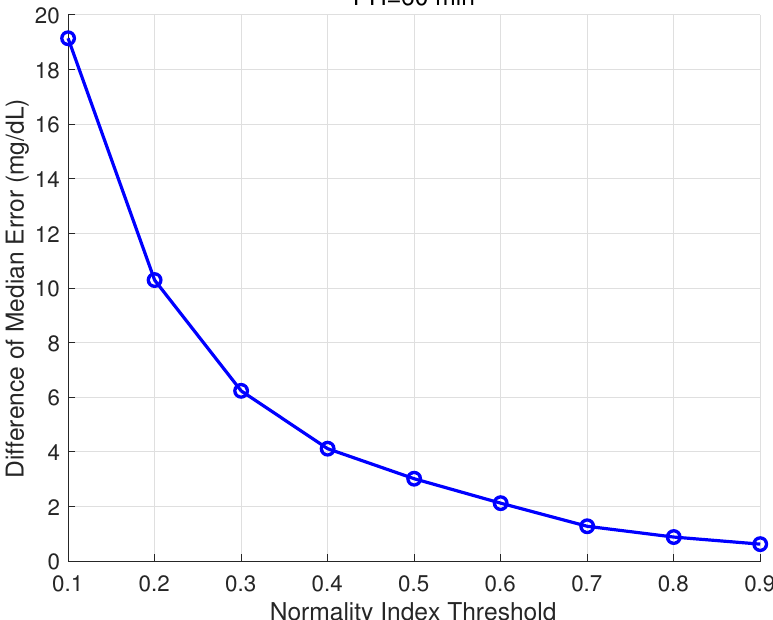
Figure 7. Relationship between Normality Index and prediction error. Difference of the median absolute value of the residual at t p + PH between groups for NI ( t p ) < NI thr and NI ( t p ) ≥ NI thr , with NI thr ranging from 0.1 to 0.9, is shown. All differences were found statistically significant ( p <